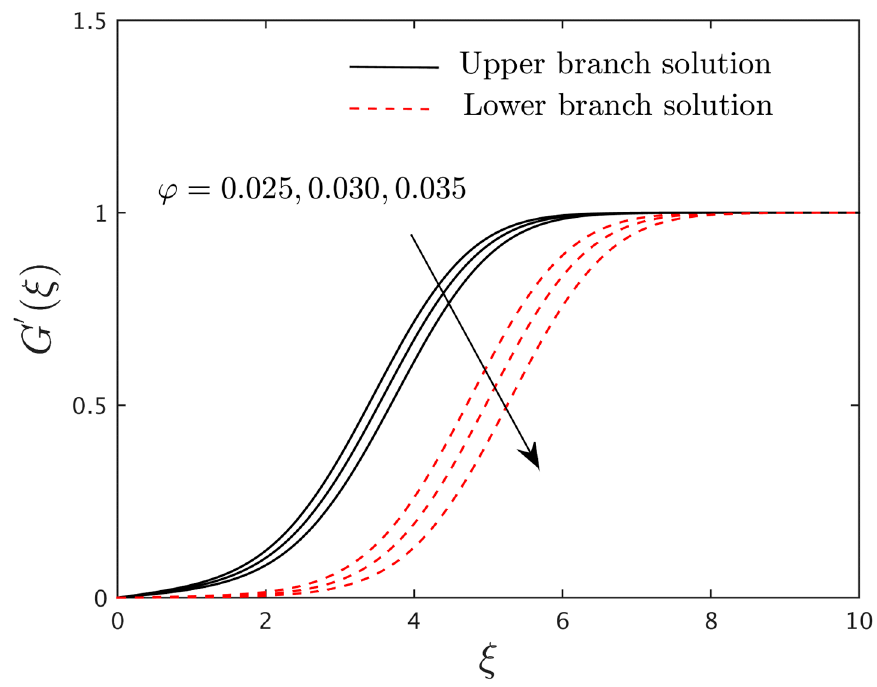
Figure 7. The induced magnetic profiles G (cid:48) ( ξ ) for the numerous values of ϕ when Pr a = 1.0, Sc a = 10.0, Pr = 6.2, Σ a = 0.05, and γ s =